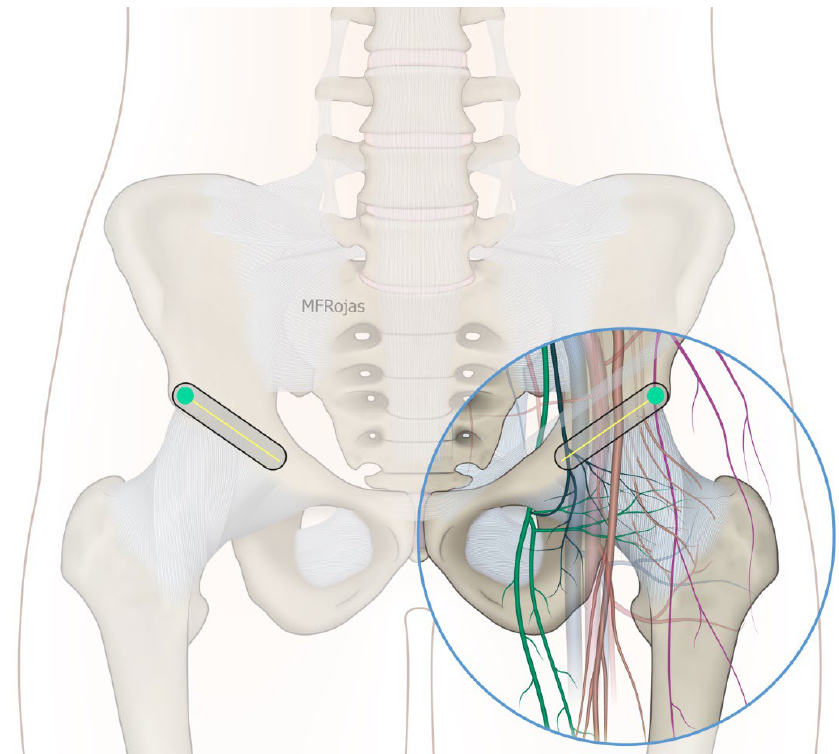
Figure 2. A schematic diagram to show how the linear probe is placed to align the AIIS and IPE. Reproduced with permission from Dr Maria Fernanda Rojas Gomez (Bucaramanga, Colombia). Green dot: transducer mark.